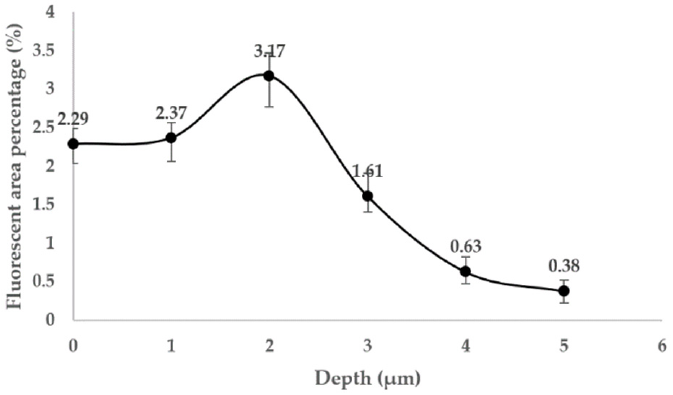
Figure 6. The percentage of damage fluorescent area.